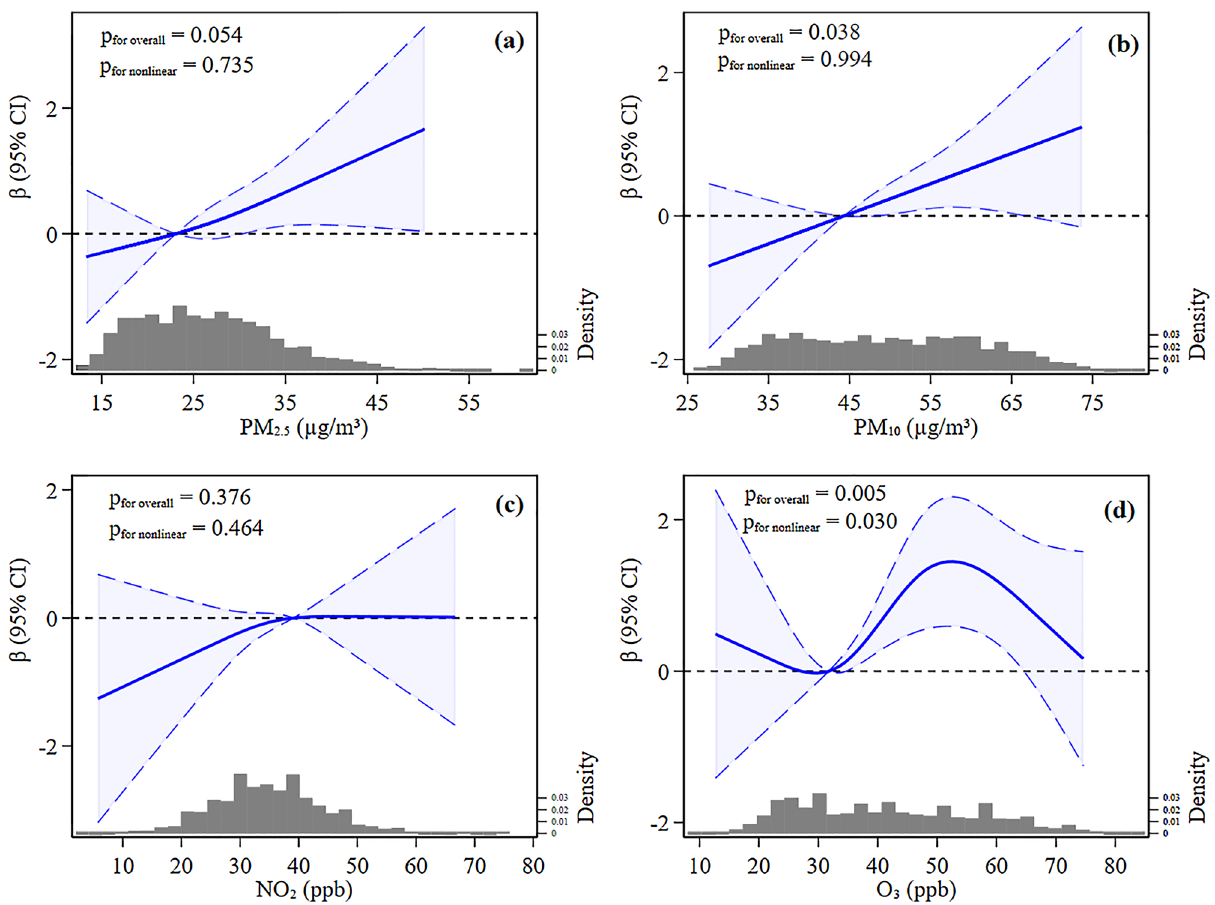
Figure 1. Nonlinear effects of PM 2.5 ( a ), PM 10 ( b ), NO 2 , ( c ) and O 3 ( d ) on PSS scores. Point estimates (solid line) and 95% confidence intervals (long dashed lines) were obtained by restricted cubic splines with three knots at the 10th, 50th, and 90th percentiles of PM 2.5 , PM 10 , and NO 2 distributions and four knots at the 5th, 35th, 65th, and 95th percentiles of the O 3 distribution. PM 2.5 and PM 10 during the second trimester, NO 2 during the first trimester, and O 3 during the third trimester were used for spline analyses. Reference PM 2.5 , PM 10 , NO 2 , and O 3 values for these plots with β fixed at 0.0 were 22.4 μg/m 3 , 43.9 μg/m 3 , 39.0 parts per billion (ppb), and 31.0 ppb, respectively. Models adjusted for maternal age, education, occupation, gestational age, maternal smoking, drinking during pregnancy, parity, pre-pregnancy BMI, season at delivery, income, asthma, thyroid 2.5 ( a ), PM 10 ( b ), NO 2 ( c ), and O 3 ( d )